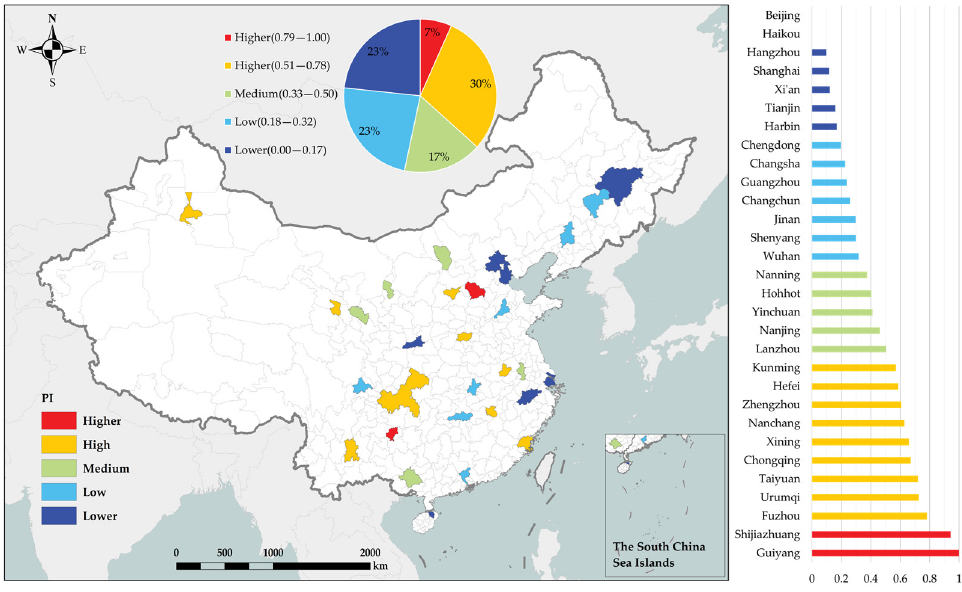
Figure 5. Pressure index map.